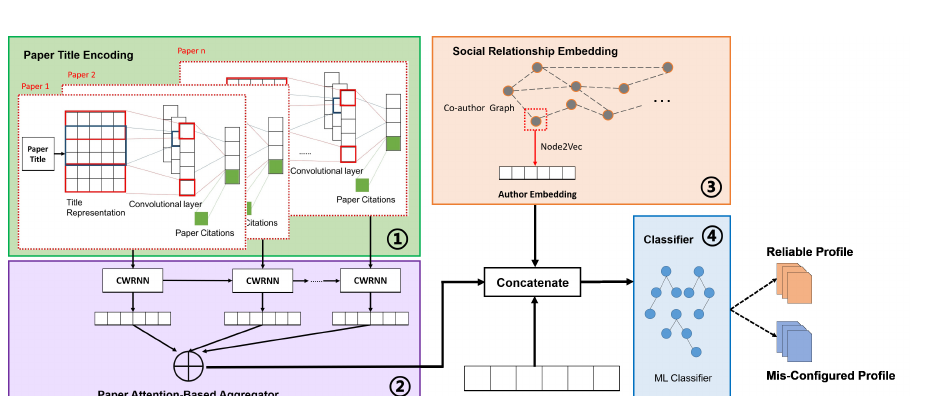
Figure 2. The architecture of the model. (1) The green box (box (cid:172) ) is the process of paper title encoding where TextCNN is leveraged. (2) The paper attention-based aggregator is shown in the purple box (box (cid:173) ), where the hidden features of different papers are produced by CW-RNN and aggregated with different weights. (3) The orange box (box (cid:174) ) shows the process to obtain the author embedding from the co-author graph. (4) The blue box (box (cid:175) ) is a machine learning classifier (we use LightGBM in this paper) to classify the author profiles based on the concatenated features. (5) The output of the models is the judgment of whether an author profile is mis-configured or